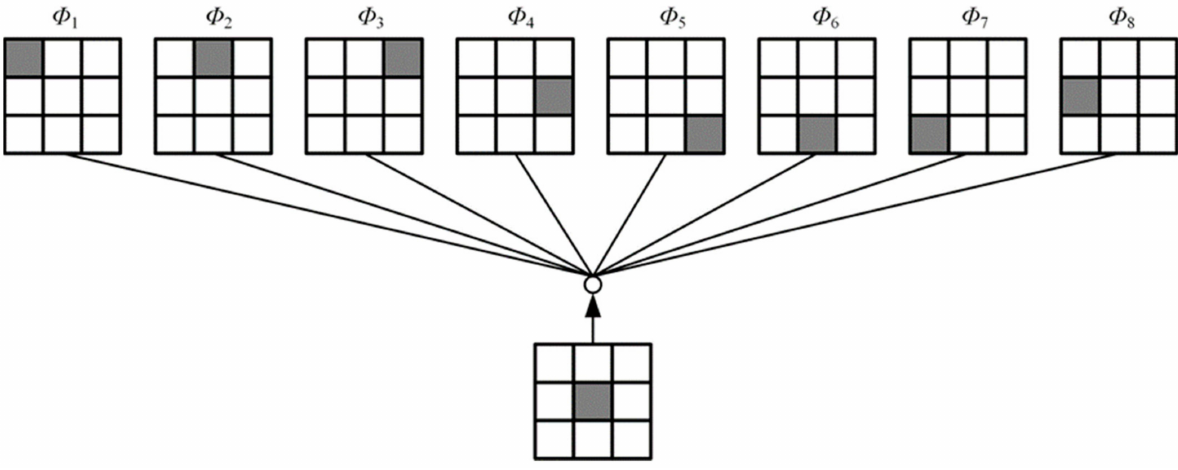
Figure 2. Schematic diagram of the registration error directions assumed for the reference pixel at N =